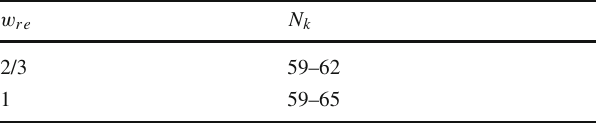
Table 4 Summary of the allowed range for the number of e -folds for each EoS parameter w re for M 5 = 10 12 TeV when the